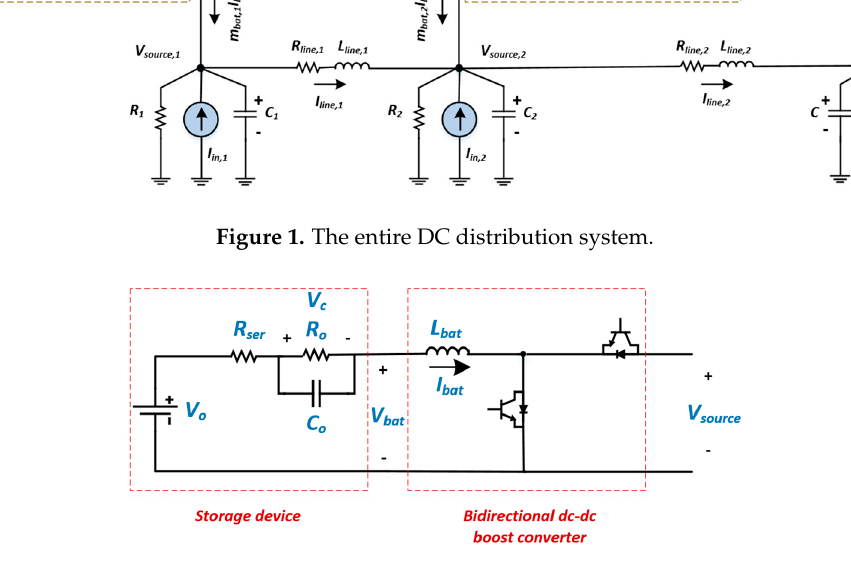
Figure 2. The battery/bidirectional DC/DC boost converter branch model.